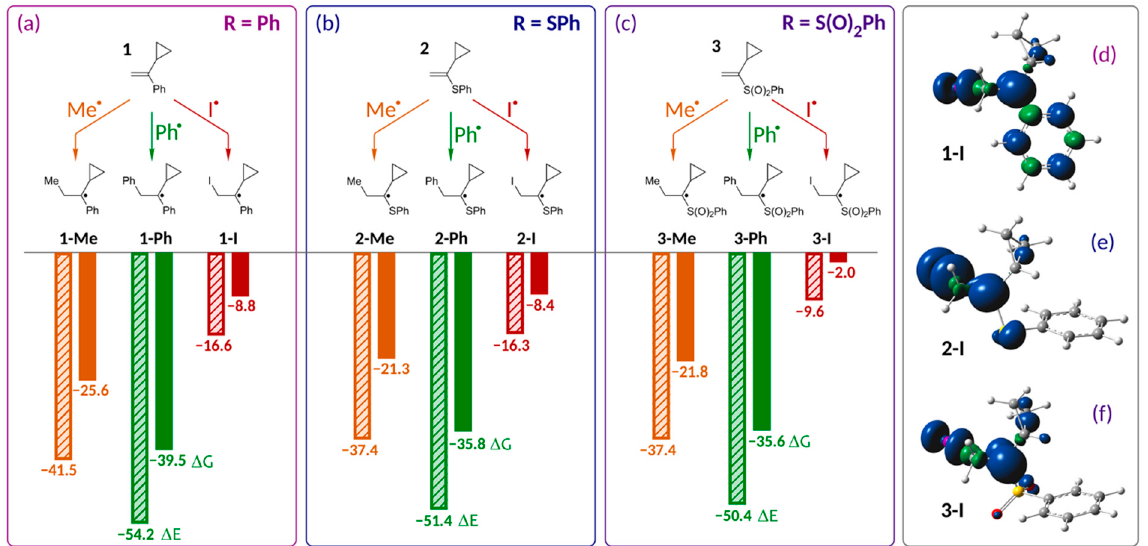
Figure 1. ( a – c ) The values of the reaction total energies Δ E (diagonal shading) and reaction free energies Δ G (solid fill, kcal/mol) for reactions of compounds 1 – 3 with different radicals. ( d – f ) Spatial distribution of spin density for products of interaction of alkenes 1 – 3 with iodine radical (Figures S3 and S4 for spin density analysis of other addition products); UPBE1PBE/6-311 + G(d,p) D3BJ level.